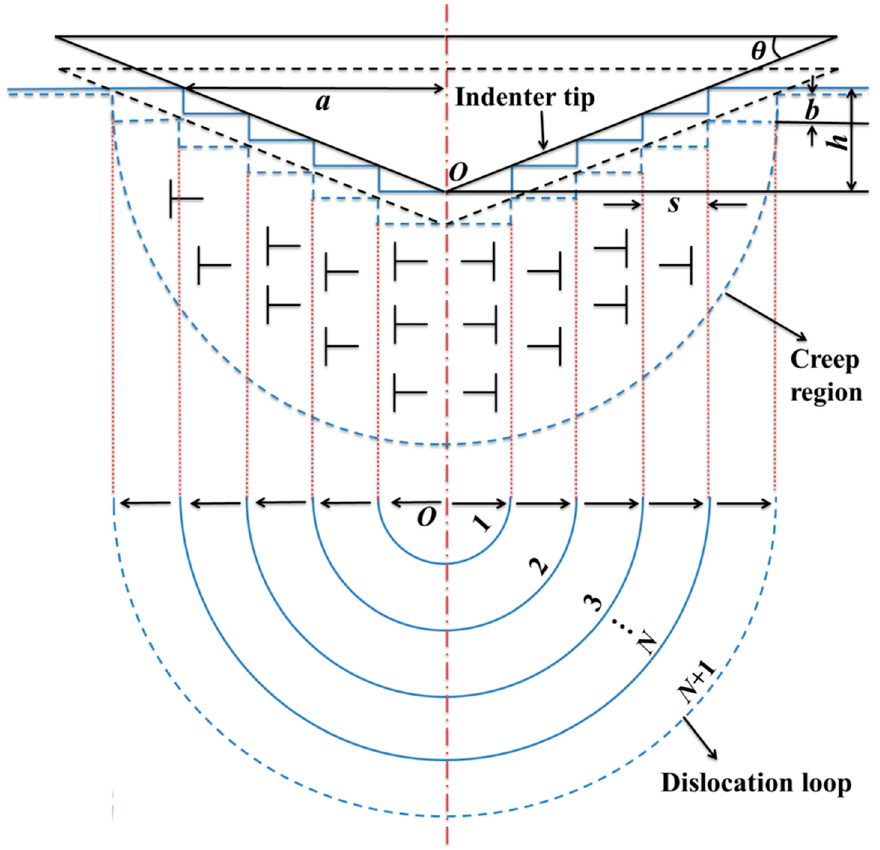
Figure 1. Schematic of indentation creep with the evolution of geometrically necessary dislocations (GNDs), which are performed by a conical indentation. When tan θ = π / 24.5 0.358 ( (cid:2016) is the angle between the indenter and sample), the model is also applicable to the Berkovich indentation following the self-similar principle [41]. The creep process is discretized into the expansion of circular dislocation loops. During each creep activation, the indenter tip moves forward by a length of b , and a new dislocation loop is generated from the indenter tip that forces existing dislocation loops to creep radially with a distance of s . Thereinto, b and s are, respectively, the magnitude of the Burgers vector and the spacing between individual dislocation loops.